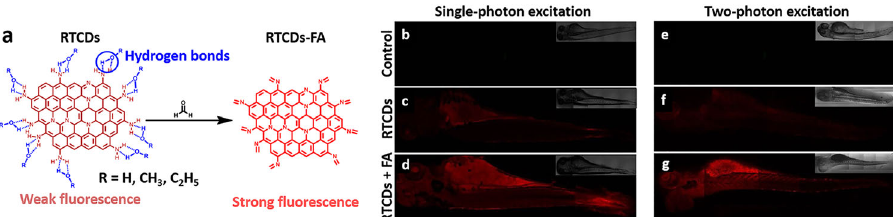
Fig. 5 RTCD sensing mechanism and in vivo sensitivity toward formaldehyde (FA). a Possible reaction mechanism of RTCD toward FA. Single-photon ( b – d ) and two-photon ( e – g ) fl uorescence images of zebra fi shes incubated with RTCDs. λ ex = 480 nm (single-photon, λ em = 500 – 700 nm); λ ex = 740 nm (two-photon, λ em = 500 – 700 nm). Scale bar = 400 μ m. (Fig. 5a – g adapted with permission from ref. 45 , Copyright 2019